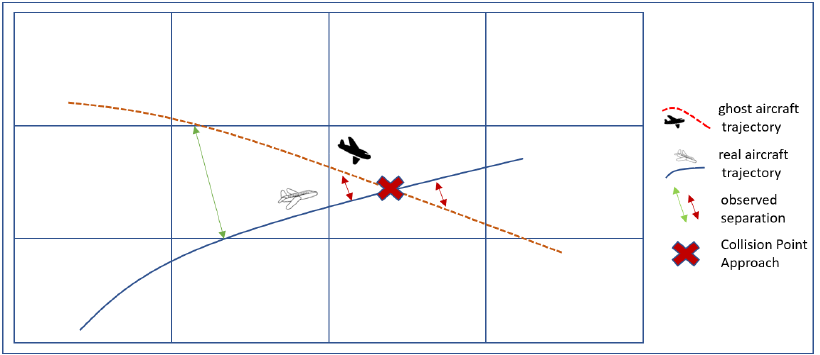
Figure 1. Closest Point of Approach (CPA) between two aircraft prior to an imminent collision between a real aircraft and a ghost aircraft based on an adaptation of CRM